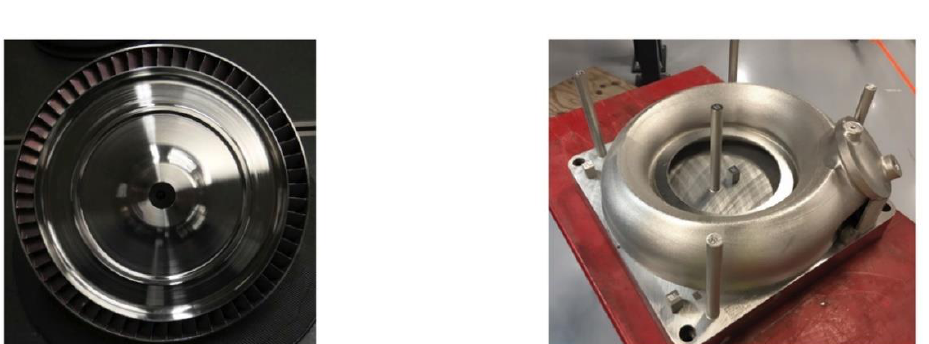
Figure 6. Burst rotor and manifold manufactured with LPBF. The manifold build plate includes travelers for tensile and microstructural evaluation. Note the ‘lid’ on the manifold inlet which was added to be able to perform the burst testing, utilizing the flexibility of the LPBF process (courtesy of GKN Aerospace).